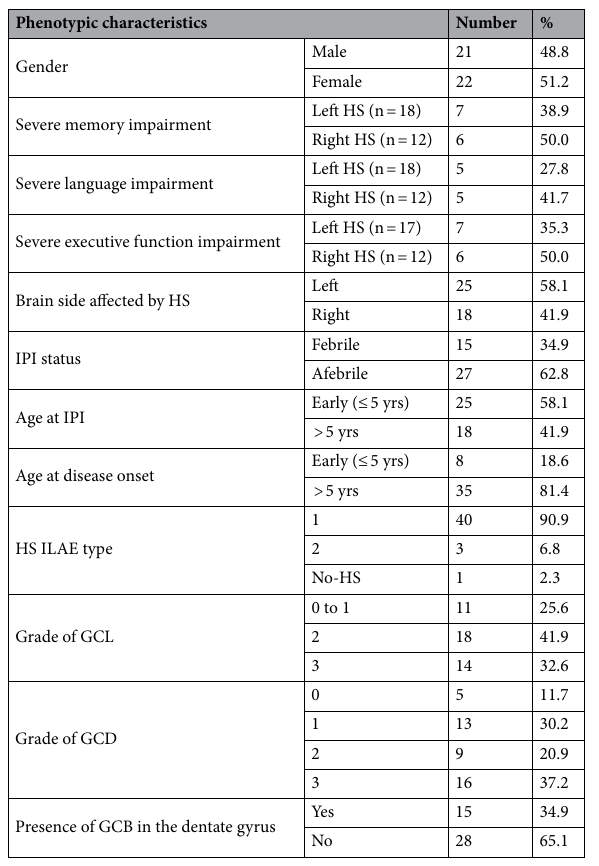
Table 1. Demographic and clinical characteristics of 43 RTMLE patients and histological features of the patients’ hippocampal